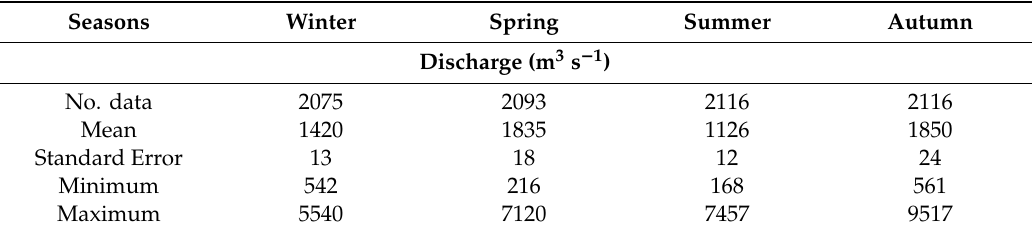
Table A1. Statistics of seasonal values of flow rate (m 3 s − 1 ) and nitrate and phosphate concentrations ( µ M) in the Po River, in